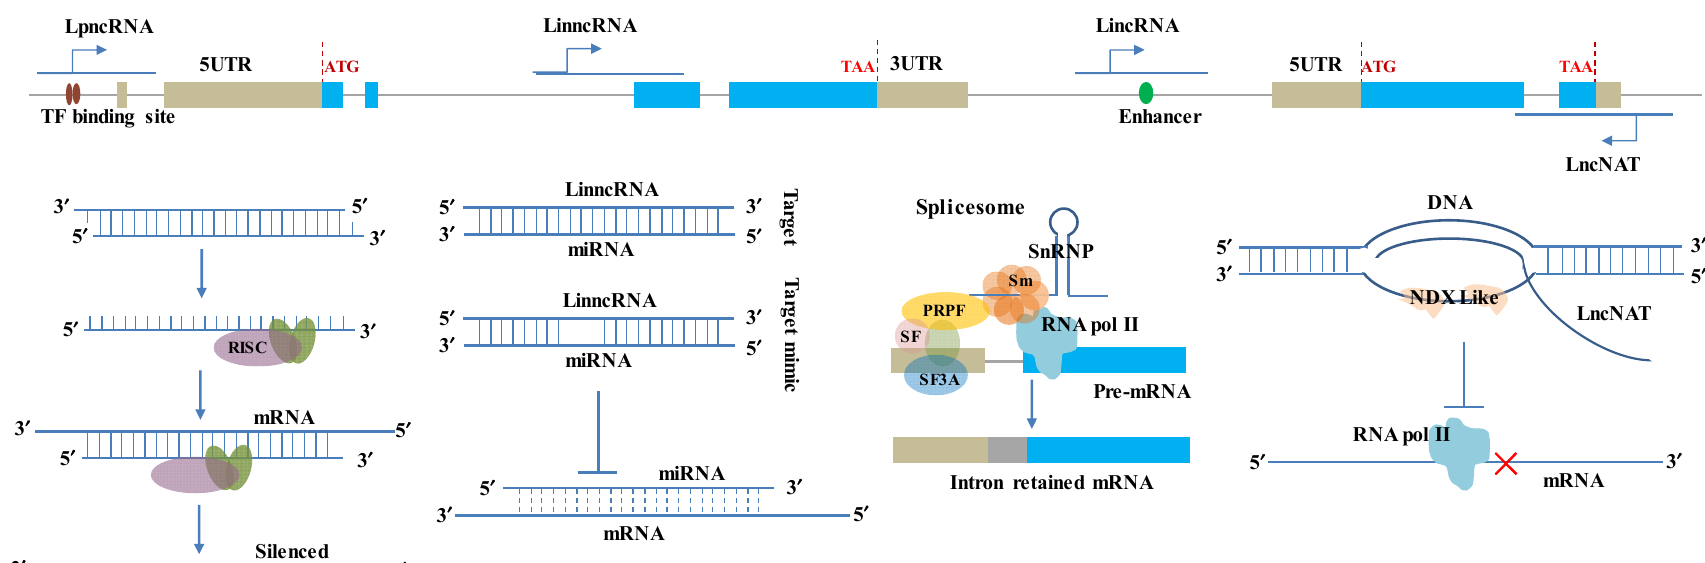
Figure 1. LncRNA Schematic illustrations for classification and regulation mechanism in functional genes. The lncRNA classes were given on the top based on the DNA sequences and cDNA sequences of two simulated tandem genes. Open reading frames (ORFs) and exons are shown as blue boxes. The introns of the genome sequences are indicated by grey lines. Untranslated regions (UTRs) are shown as beige boxes. The regulation mechanism of lncRNA in functional genes was simulated in the bottom panel, including miRNA precursors, competitor / decoy (miRNA target / target mimic), alternative splicing, and R-loop. The dash lines represent the alignment probability between miRNA and mRNA was reduced due to competition by lncRNAs. The outline and shapes of spliceosome complexes tethering lncRNA are purely schematic; their size and number have no meaning. ‘Sm’ indicates the seven Sm proteins, i.e., B, D1, D2, D3, E, F, and G; ‘PRPF’ and ‘SF’ mean pre-mRNA processing factor and splicing factor; snRNPs contain the indicated lncRNA (containing an Sm site bound to RNA-binding protein) plus stably bound proteins, many of which are shared with the major spliceosome. SnRNP association with RNA polymerase II in the spliceosome has only been inferred to date. The regulated genes could be any potentially functional gene, including pathogen perception and signal transduction-related genes, R genes, their regulator (transcription and splicing factors), and so on.